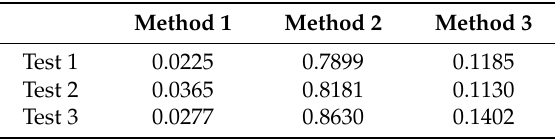
Table 4. Average values of stability evaluations.